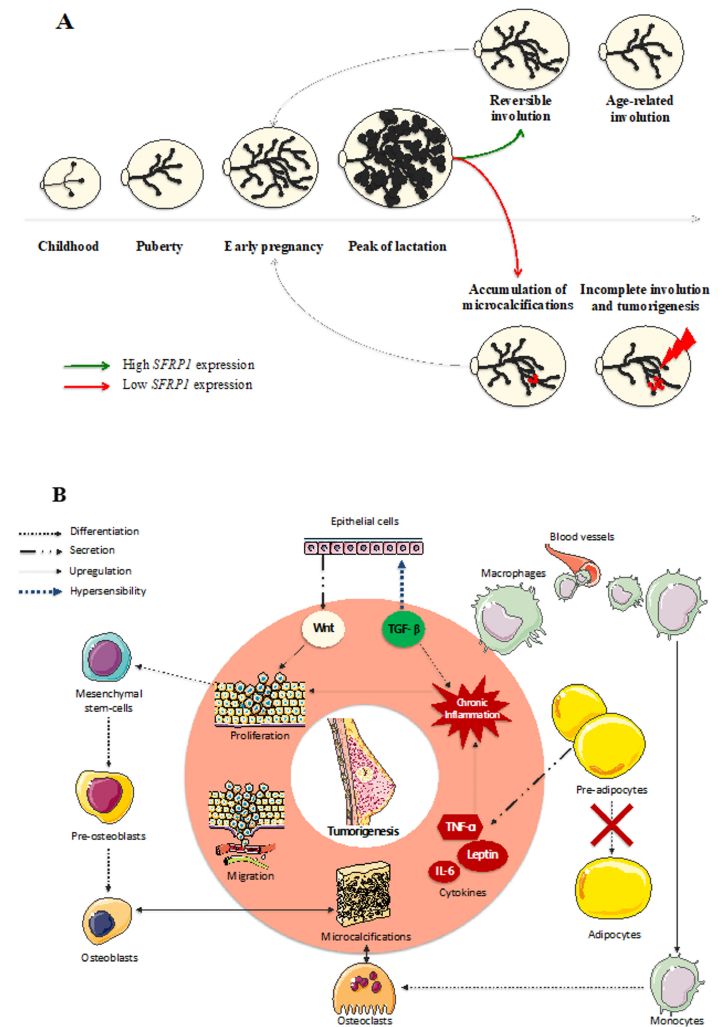
Figure 2. SFRP1 downregulation in breast tissue induces a chain reaction responsible for the malignant transformation of the cells. ( A ) Mammary glands evolve throughout a woman’s life until reaching their growth peak during breastfeeding. Afterwards, acinis remain useful, so the breast starts a reversible involution to destroy the excessive glandular and epithelial tissue. During the peri-menopausal step of a woman’s life, another involution appears to eliminate the rest of the useful tissue, decreasing at the same time the risk of breast cancer development. As a down-regulator of cell growth, SFRP1 under-expression could be responsible for the incomplete age-related breast involution resulting in a malignant transformation of the breast in the presence of microcalcifications. ( B ) The over-activation of the Wnt signaling pathway due to the SFRP1 down-regulation in breast tissue is responsible for the increasing proliferation and migration of mammary cells. The local inflammation needed to start the physiological age-related breast involution is responsible for the recruitment of the immune system. In the presence of microcalcifications, monocytes are able to di ff erentiate in osteoclasts, while mesenchymal stem cells can di ff erentiate in osteoblasts responsible for de novo microcalcifications formation. Furthermore, the replacement of epithelial tissue by adipose tissue needs pre-adipocytes maturation which is downregulated by the under-expression of SFRP1 . The production of adipokines by immature adipocytes generates a chronic inflammation exacerbated by the hypersensitivity of epithelial cells to TGF- β due to the SFRP1